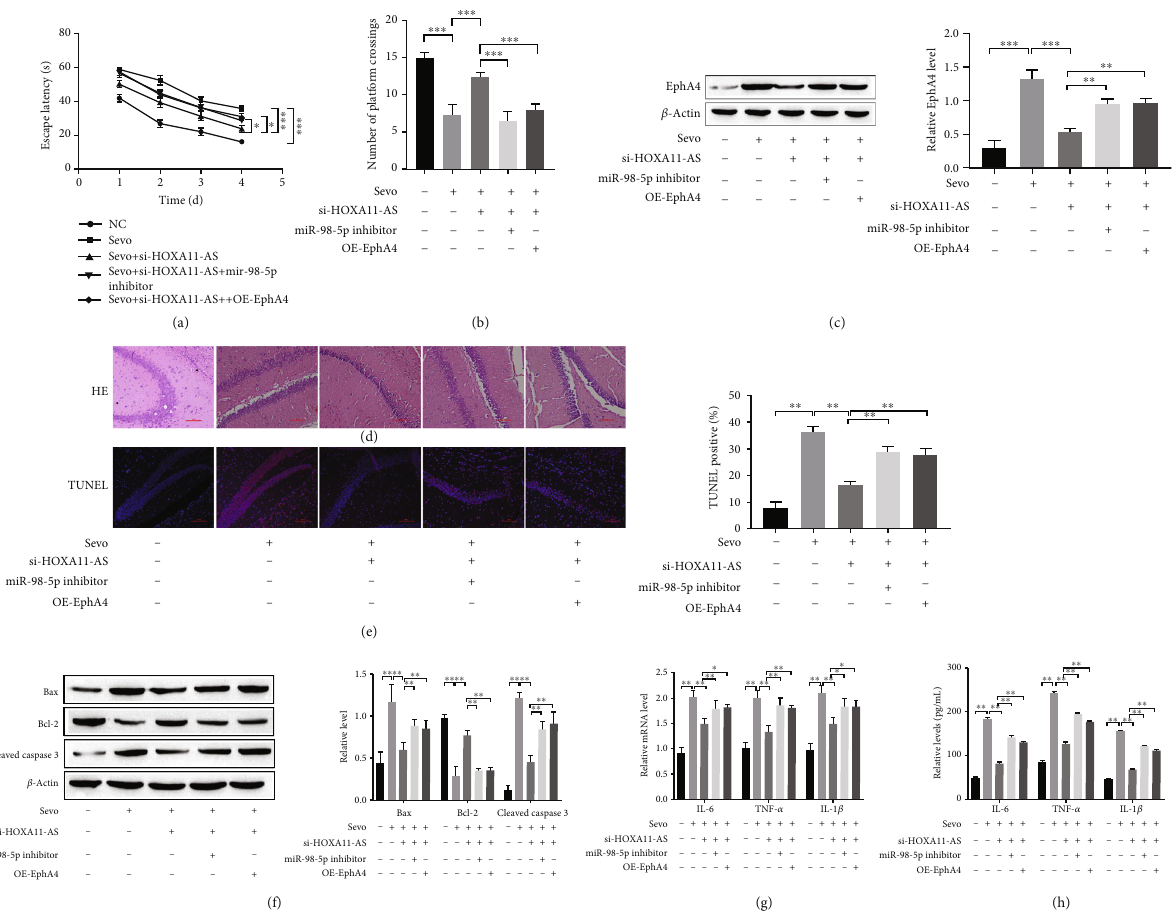
Figure 7: HOXA11-AS alleviates the cognitive impairment caused by sevo fl urane in rats through the miR-98-5p/EphA4 molecular axis. After 3 days of anesthesia, the hippocampal tissue was taken for the following experiments: (a, b) MWM test to detect escape latency and the number of platform crossings. (c, f) Western blot detection of protein expression in rat hippocampus. (d) HE staining to detect rat hippocampal tissue pathological phenomena. (e) TUNEL staining to detect rat hippocampal tissue nerves apoptosis. (g) RT-qPCR detect the mRNA expression of in fl ammatory factors. (h) ELISA detects the in fl ammatory factors levels in rat hippocampus. ∗ P < 0 : 05 , ∗∗ P < 0 : 01 , ∗∗∗ P < 0 : 001